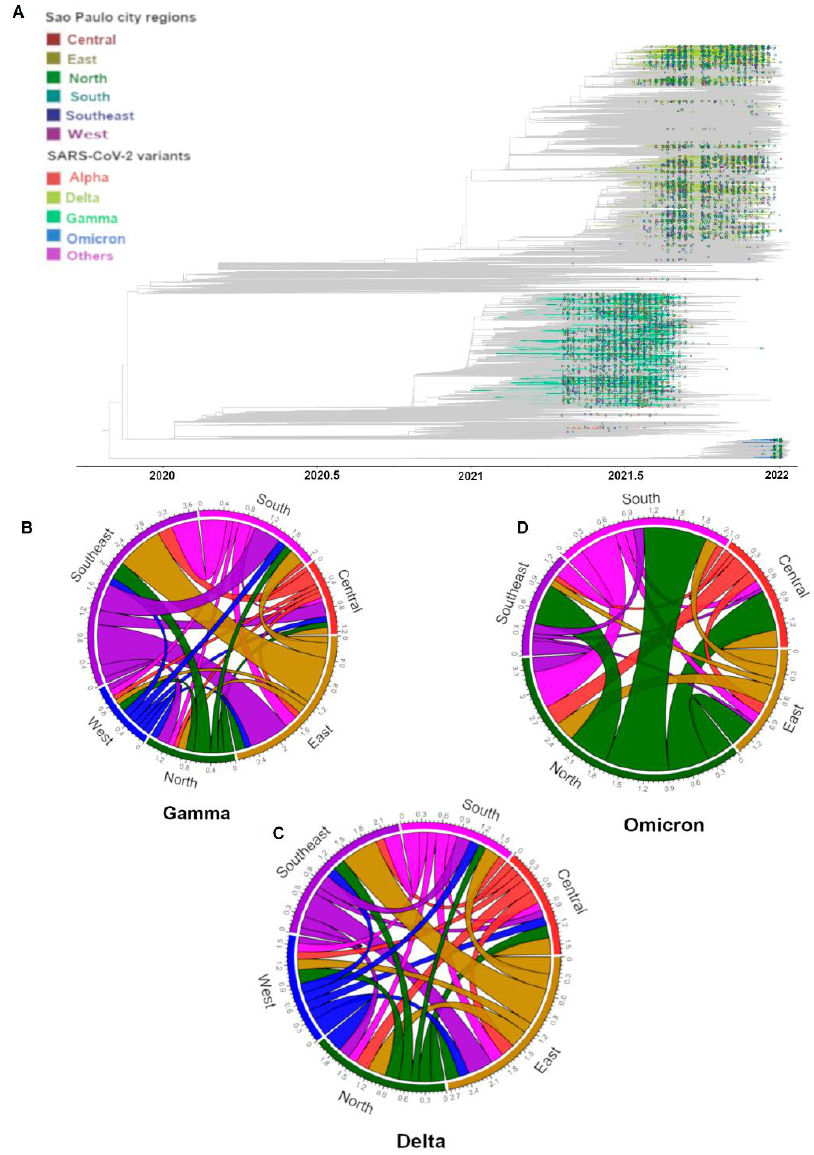
Figure 3. Phylogenetic analysis and SARS-CoV-2 lineage dynamics in the city of S ã o Paulo, Southeast Brazil. ( A ) Time-resolved maximum likelihood phylogeny containing high-quality near-full-genome sequences from the city of S ã o Paulo (n = 9995) obtained from this study, and analyzed against a backdrop of global reference sequences (n = 33,154). Variants of concern (VOC) are highlighted on the phylogeny. ( B – D ) Number of viral exchanges within S ã o Paulo macro-regions by counting the state changes from the root to the tips of the phylogeny in panel B – D.